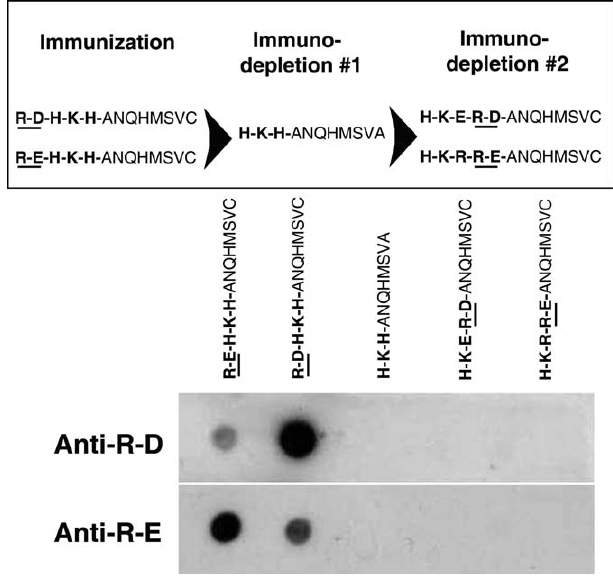
Figure 3. Generation of the Antibodies to N-Terminal Arg Top: antibody generation strategy showing the sequences of the peptides used for antibody production and immunodepletion to ensure antibody specificity for Arg in the N-terminal position. Bottom: dot blot of the affinity-purified antibodies to N-terminal Arg–Asp and Arg–Glu sequences against the peptides listed on the top. doi:10.1371/journal.pbio.0050258.g003 PLoS Biology |